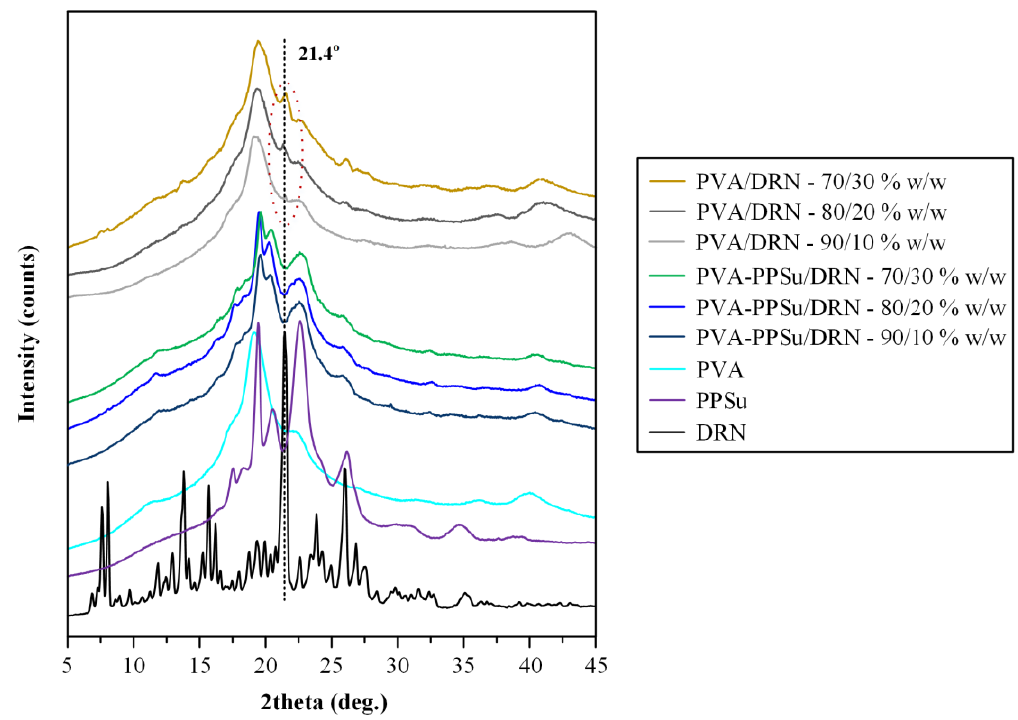
Figure 8. pXRD diffractograms of all raw materials along with PVA/DRN and PVA-PPSu/DRN ASDs at several weight ratios.